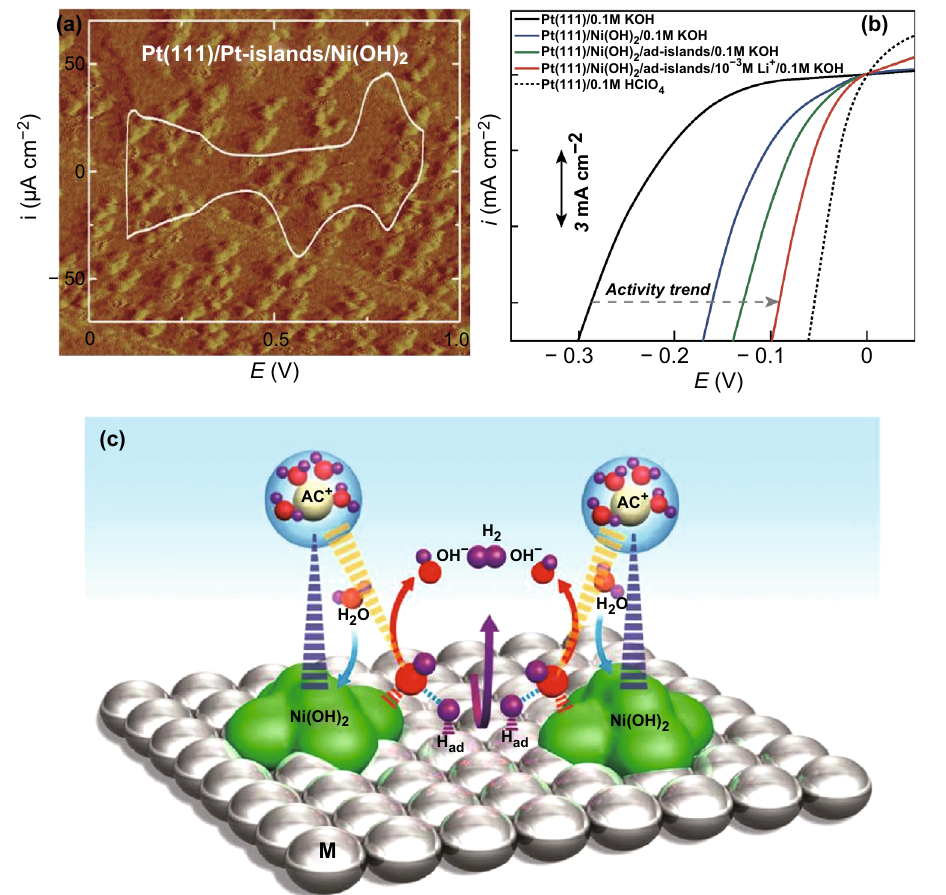
Fig. 1 a STM image (60 nm 9 60 nm) and CV trace of the Pt/Ni(OH) 2 surface. b Comparison of HER activities of Ni(OH) 2 -modified Pt electrode and control samples in 0.1 M KOH. c Schematic representation of water dissociation, formation of M–H ad intermediates, and subsequent recombination of two H ad atoms to form H 2 (magenta arrow), as well as OH - desorption from the Ni(OH) 2 domains (red arrows) followed by adsorption of another water molecule on the same site (blue arrows). Reproduced with permission of the authors of Ref.